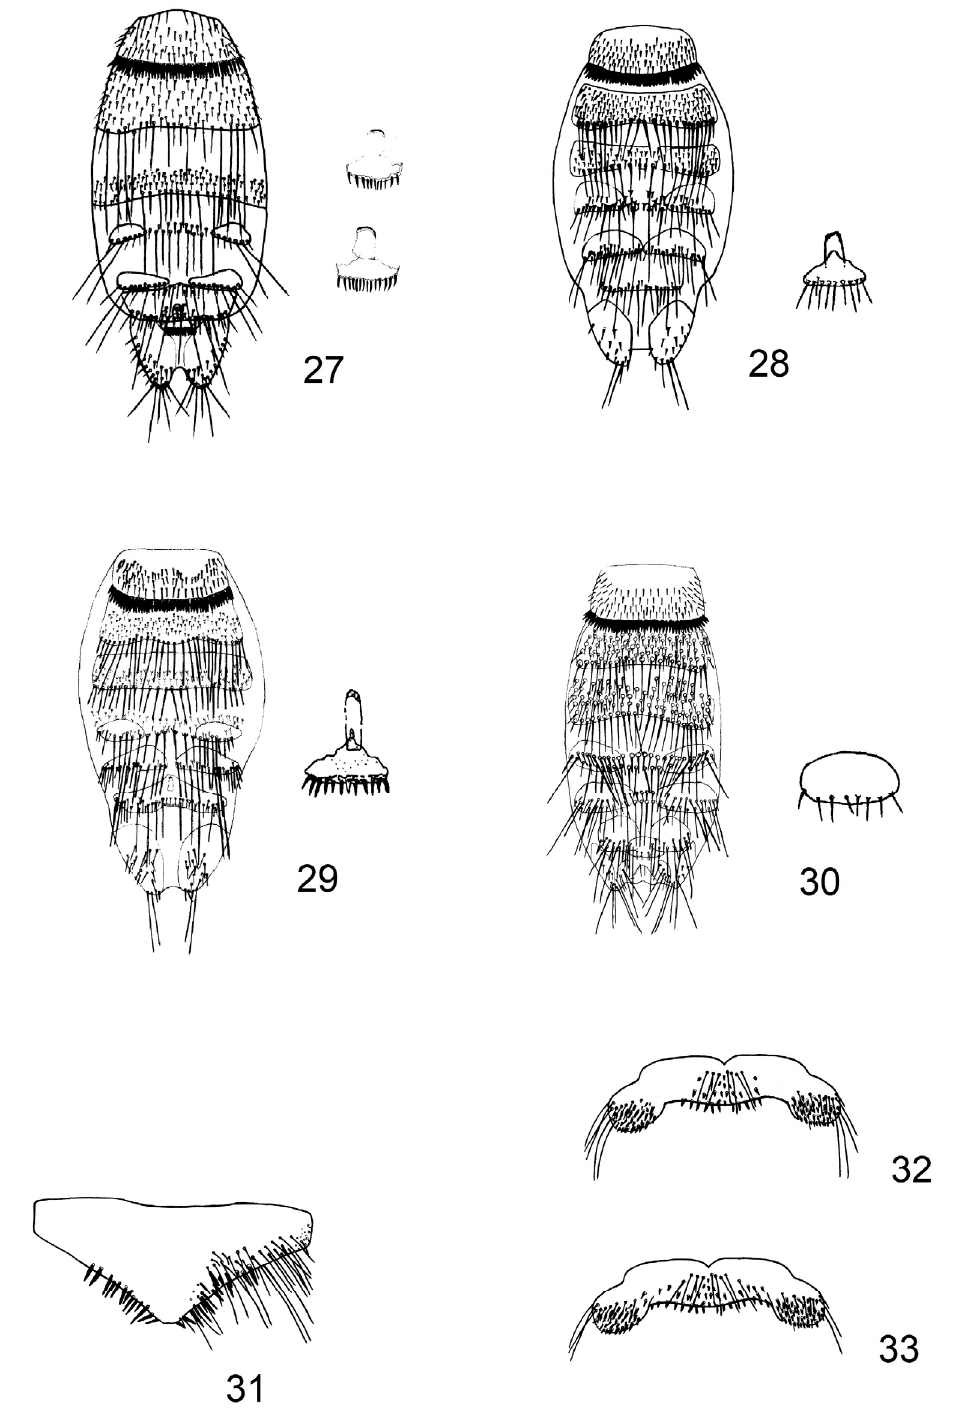
Figure 4. ( 27 ) Nycteribia ( Nycteribia ) latreillii (Leach, 1817), female, abdomen, genital plate; ( 28 ) Nyc- teribia ( Nycteribia ) kolenatii Theodor and Moscona, 1954, female, abdomen, genital plate; ( 29 ) Nycteribia ( Nycteribia ) pedicularia Latreille, 1805, female, abdomen, genital plate; ( 30 ) Nycteribia ( Nycteribia ) schmidlii Schiner, 1853, female, abdomen, genital plate; ( 31 ) Penicillidia ( Penicillidia ) conspicua Speiser, 1901, male, sternite 5; ( 32 ) Penicillidia ( Penicillidia ) dufourii dufourii (Westwood, 1835), male, sternite 5; ( 33 ) Penicillidia ( Penicillidia ) monoceros Speiser, 1900, male, sternite